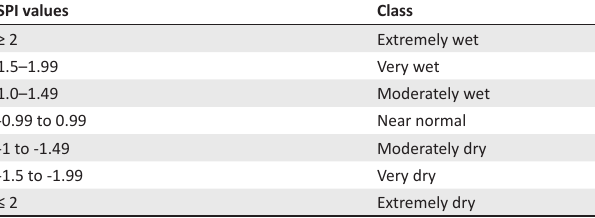
TABLE 1: Drought classification based on Standard Precipitation